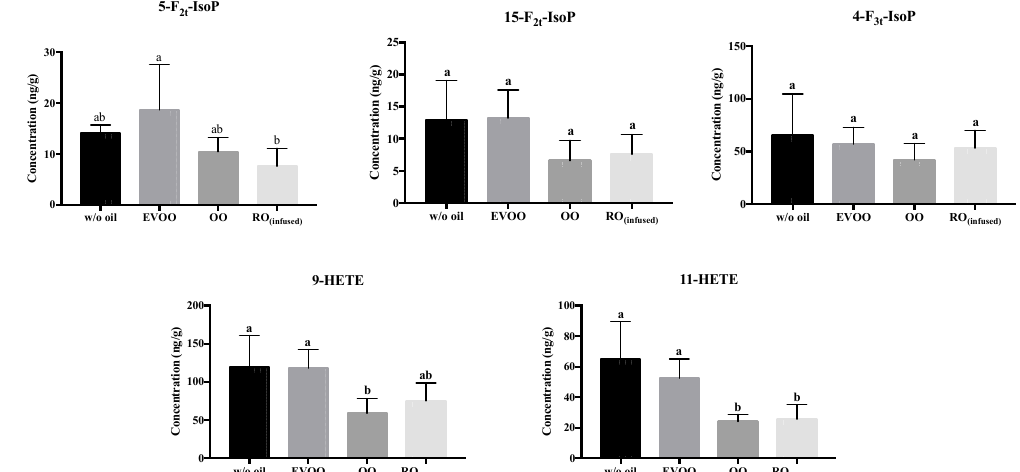
Figure 4. Concentration of non-enzymatic oxidized products of n-6 polyunsaturated fatty acid (PUFA) in pan-fried salmon samples (ng of analytes per g of salmon meat). F 2 -isoprostanes and HETEs are derived from arachidonic acid (ARA) and 4-F 3t -IsoP is derived from n-6 DPA. Data presented are mean ± S.D. ( n = 6). w / o oil: without oil; EVOO: extra virgin olive oil; OO: olive oil; RO (infused) : rosemary-infused oil. Columns sharing different alphabets are significantly different at least p < 0.05.